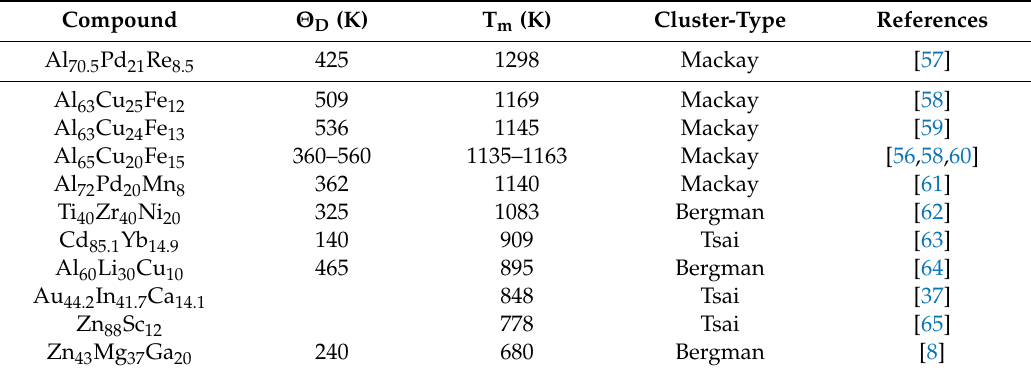
Table 3. Debye ( Θ D ) and melting (T m ) temperatures of i-QCs belonging to di ff erent alloy systems listed by their decreasing melting temperature